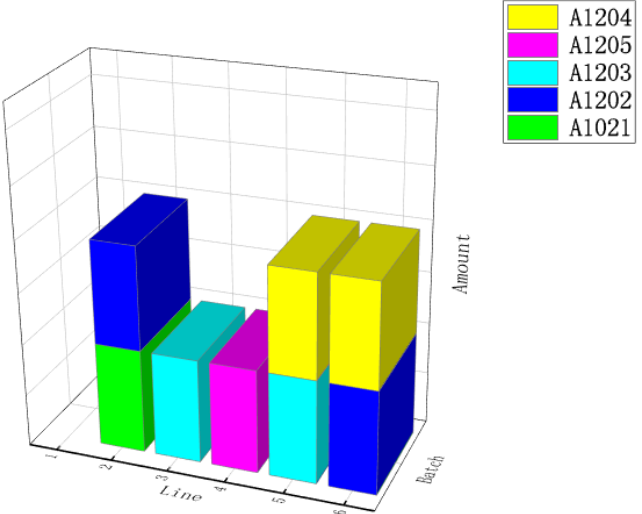
Figure 10. Identification tampering test diagram.